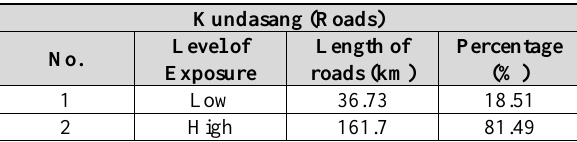
Table 12. Level of road exposure toward hazard in